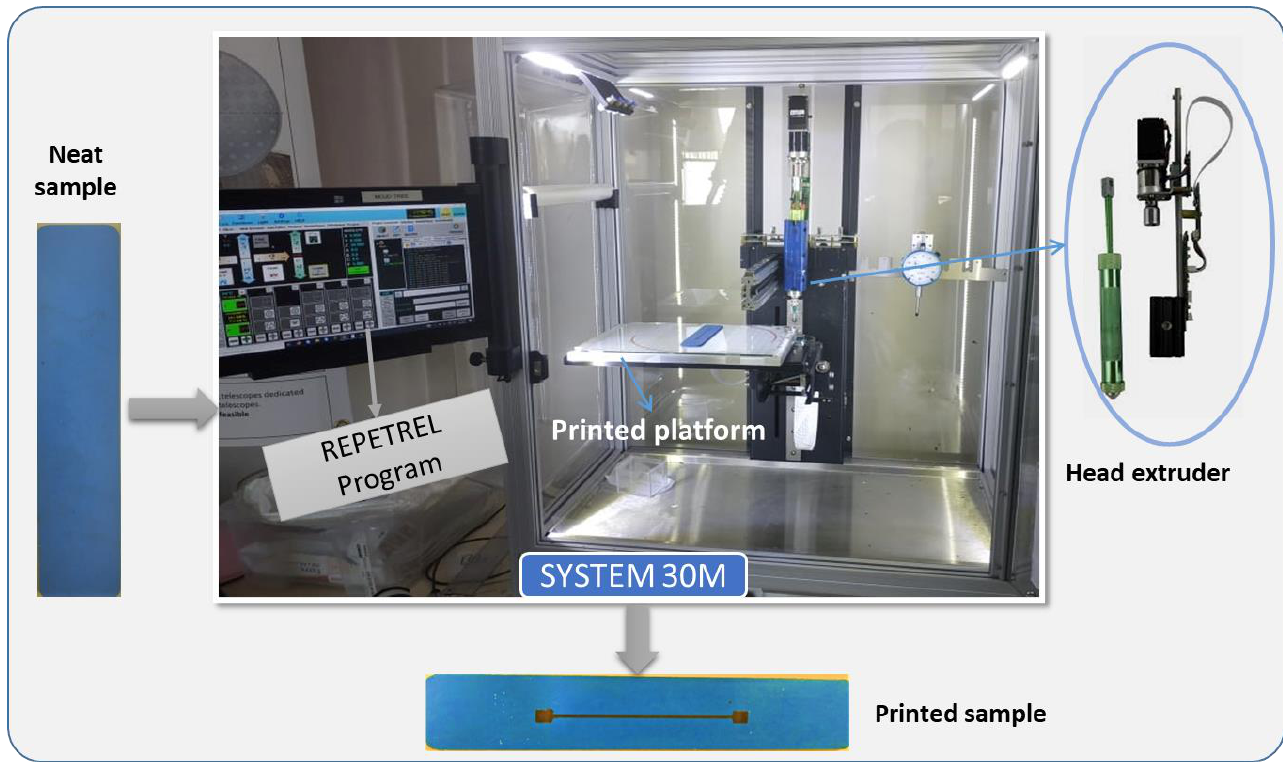
Figure 3. The printing process used to make one printed-line coating on a 2D sample.